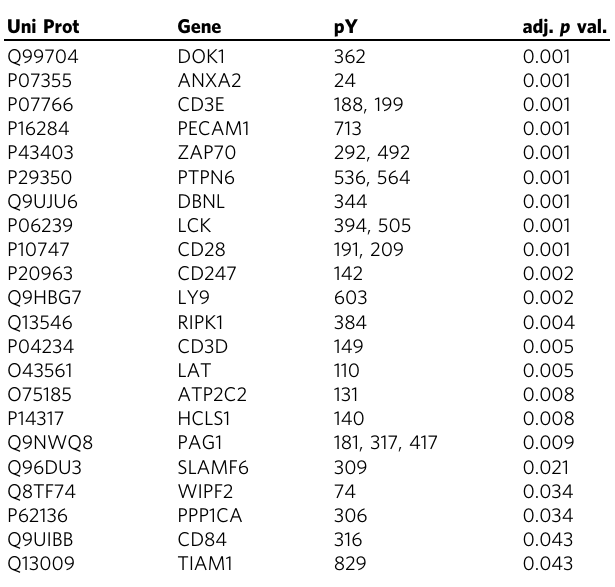
Table 1 Plasma membrane proteins that were phosphorylated downstream of PD-1 signaling. Uni Prot Gene pY adj. p